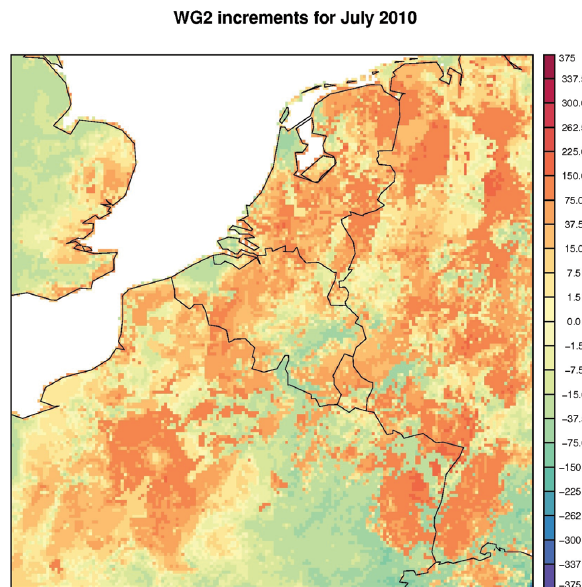
Fig. 14. Deep soil moisture increment accumulated over the month of July 2010, produced by EKF analysis where SWI is kept between 0 and 1.